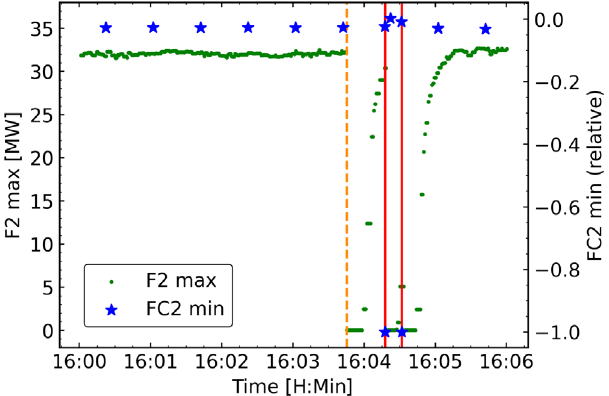
FIG. 12 Maximum value of the structure input power amplitude of the forward traveling wave (F2 max) and minimal value of the downstream Faraday cup signal (FC2 min) during the experiment to predict breakdowns. The orange dashed line shows an inter- lock, activated by a threshold on the pressure signal, meant to prevent a breakdown. The maximum structure input power amplitude of the forward traveling wave is logged as a feature in the trend data every 1.5 seconds. The minimal value of the downstream Faraday cup signal is extracted from the event data according to Fig. 6.